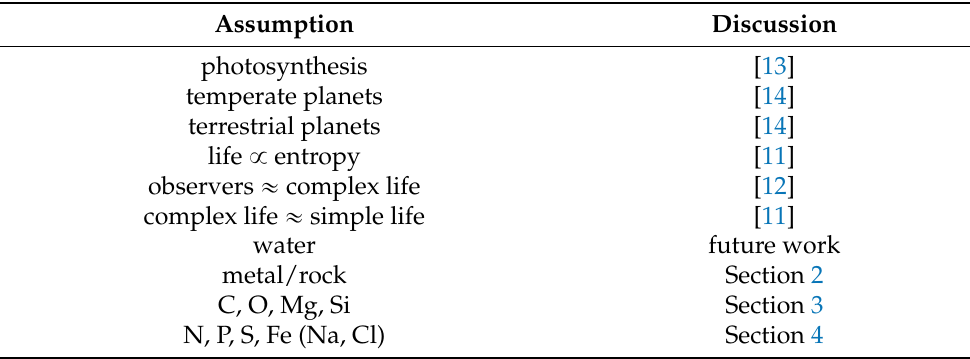
Table 1. List of habitability conditions assumed/examined in this work. Each condition is assumed necessary for habitability, with justification/analysis provided in the specified locations. Conditions not explicitly mentioned, such as the importance of tidal locking or the properties of water, are by default assumed not to be relevant for habitability in this work, but many have been/will be examined in other papers of this